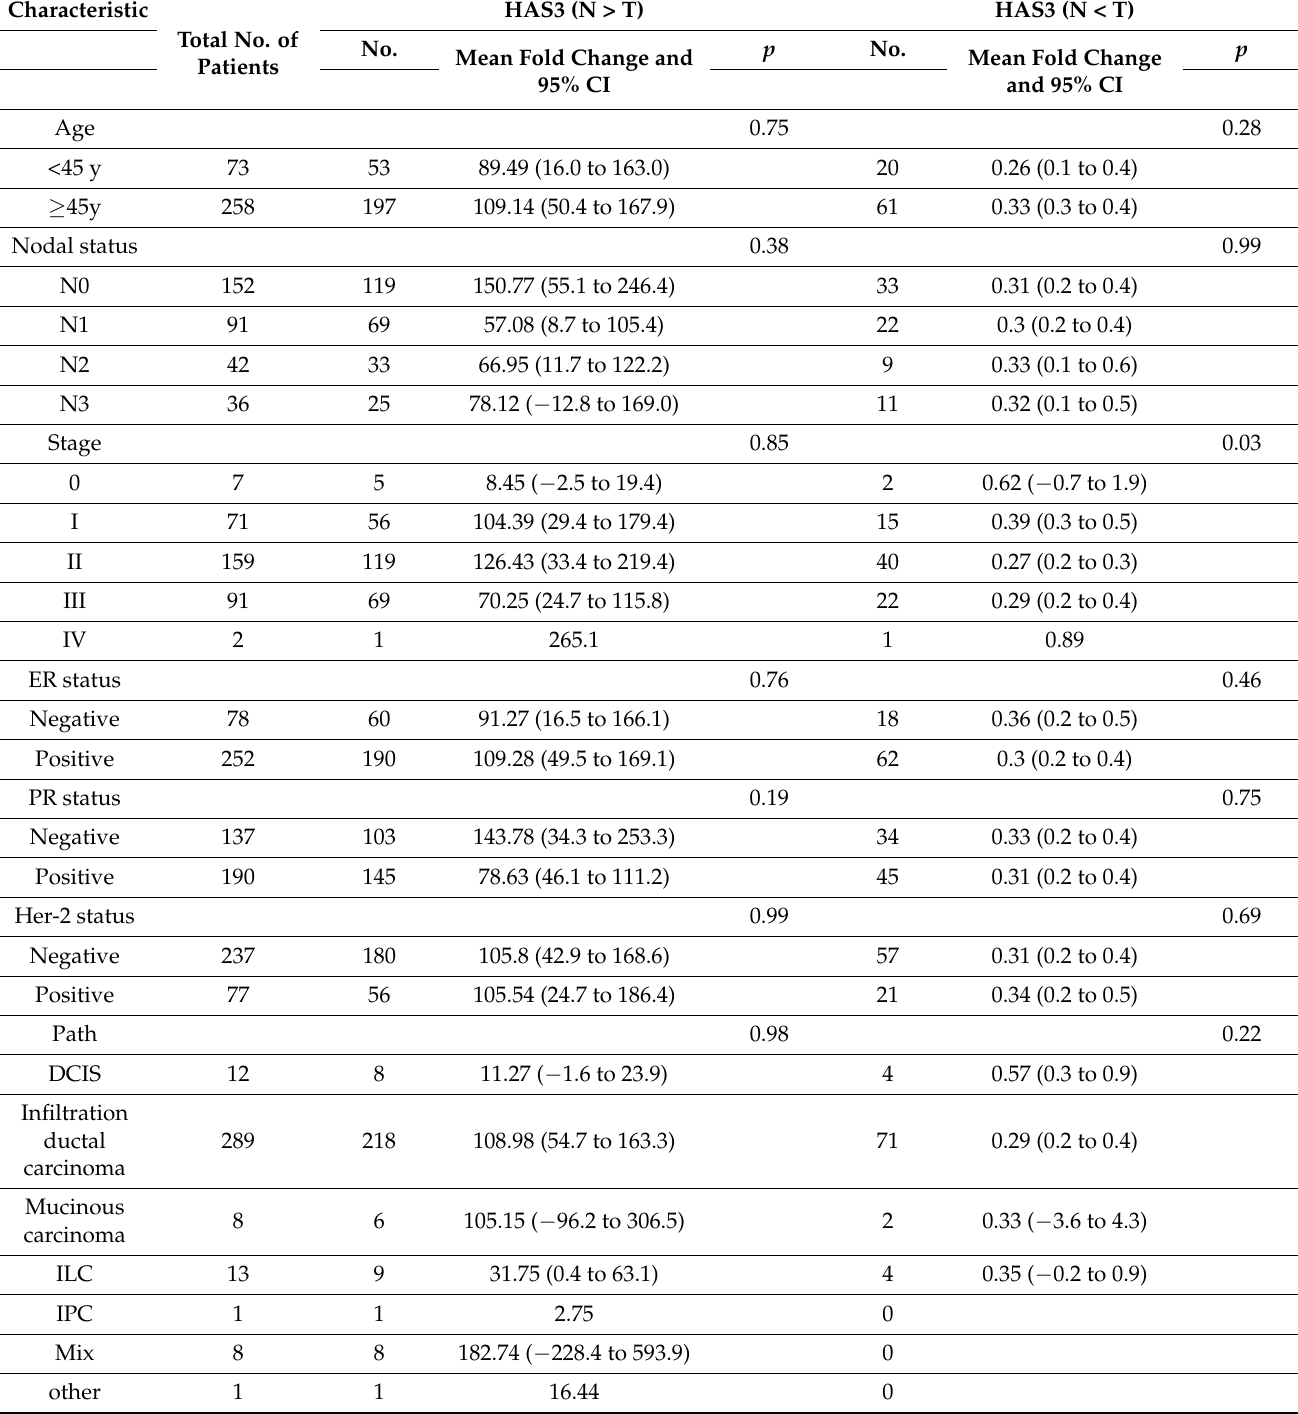
Table 1. Demographic evaluation of clinical criteria and HAS3 mRNA expression fold changes between tumor vs. normal paired